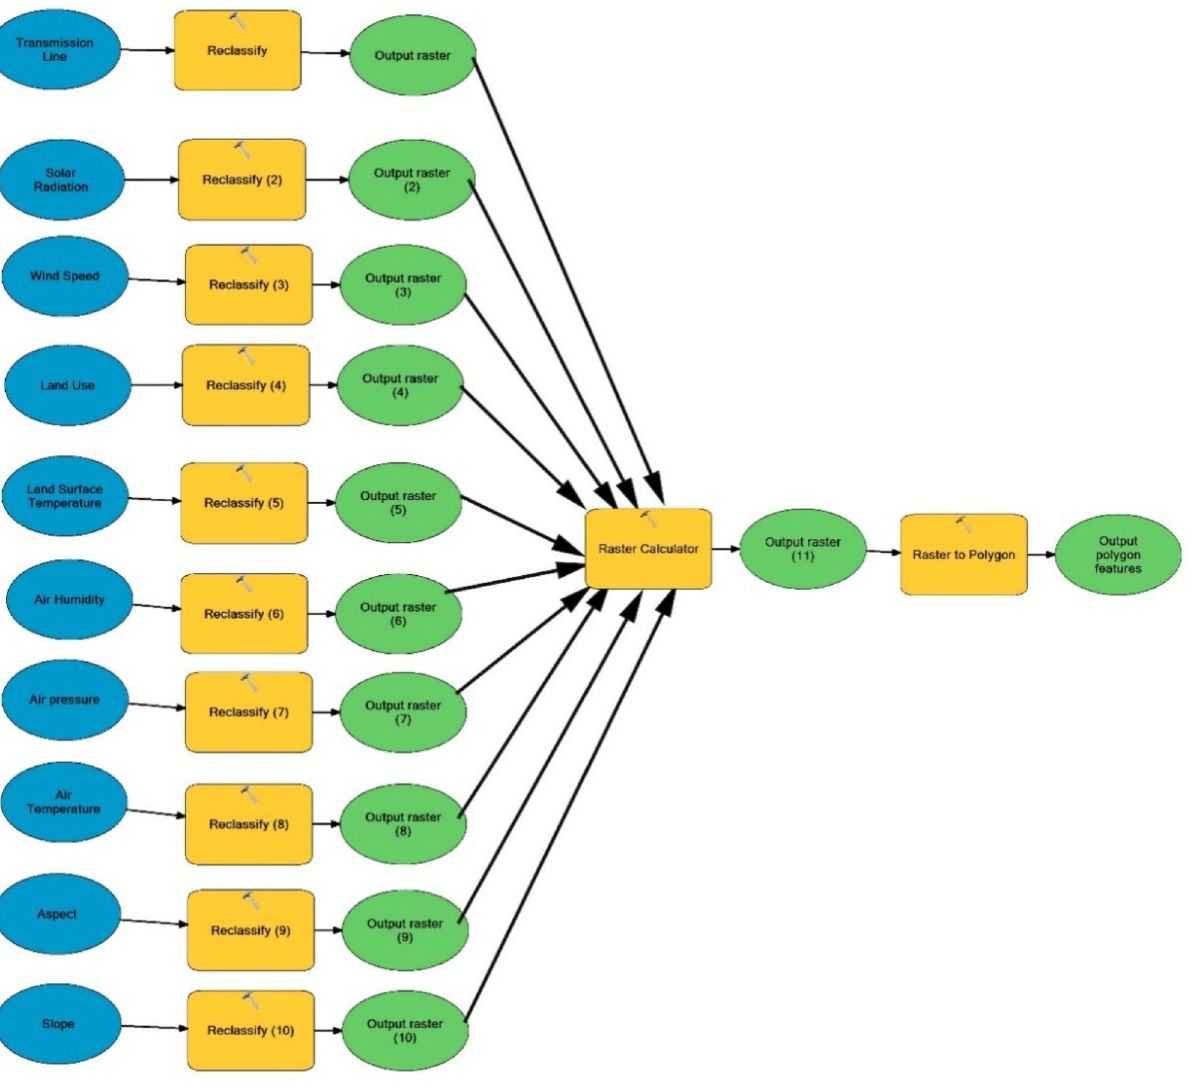
Figure 13. Model created for study result